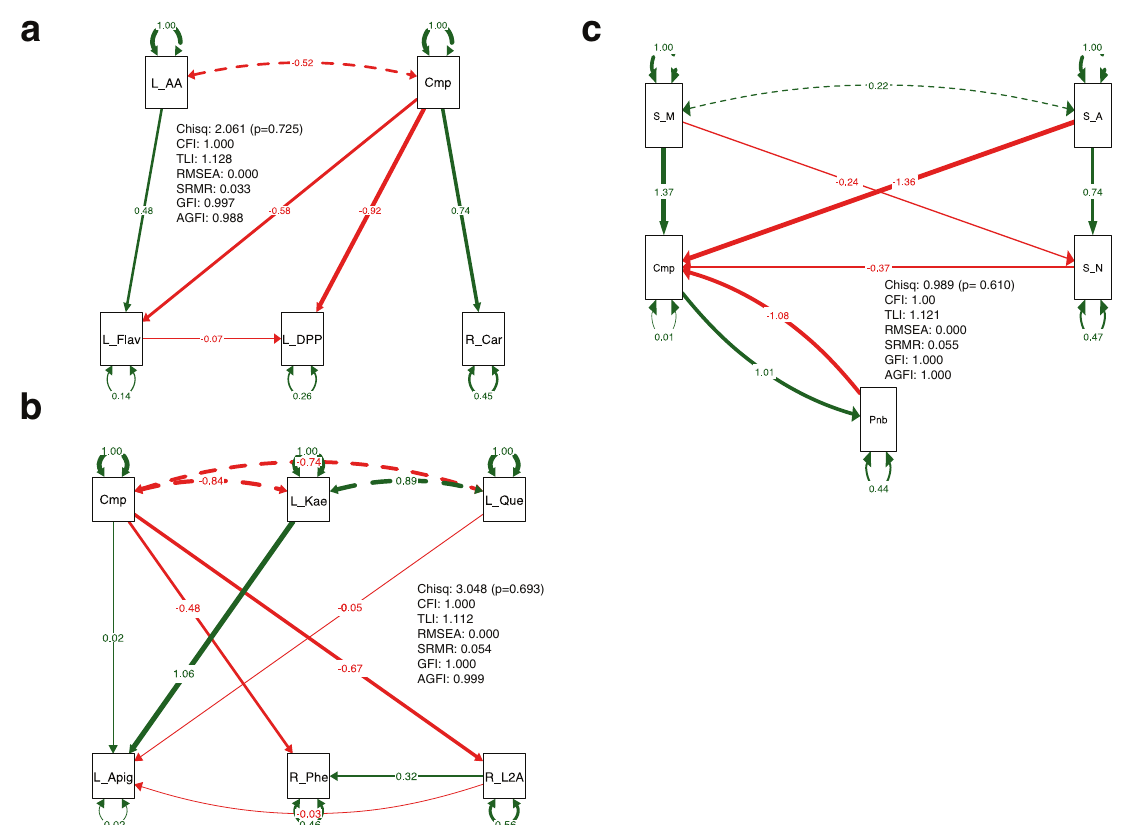
Fig. 5 The relationship of the leaf and root metabolite candidates associated with compost amendment was visualized by structural equation modeling in the regression groups selected in Tables S1 and S2. Standardized β coef fi cients are reported. The green and red colors show positive and negative associations, respectively. a Shows the sempath linked with amino acids, carotenoids, fl avonoids, DPPH activity, and compost. b Shows the sempath linked with apigenin 7-O-neohesperidoside, kaempferol-Gal-Rha, and quercetin Glc as fl avonoids in the leaf and L-2-aminoadipate and phenylalanine in the root and compost. c Shows the sempah linked with soil metabolites, Paenibacillus , and compost.The abbreviations are as follows: Cmp, compost; L_AA, total amino acid contents in the leaf; L_Fav, total fl avonoid contents in the leaf; L_DPP, DPPH activities in the leaf; R_Car, total carotenoid contents in the root; L_Apig, apigenin 7-O-neohesperidoside in the leaf; L_Kae, kaempferol-Gal-Rha in the leaf; L_Que, quercetin Glc in the leaf; R_L2A, L-2-aminoadipate in the root; R_Phe, phenylalanine in the root; Pnb, Paenibacillus ; S_A, L-2 aminoadipate; S_N, nicotinamide; S_M, S -methyl L-cysteine. The fi t indices are shown in the path as follows: Chiq, chi-square χ 2 ; p value, p values (chi-square); CFI comparative fi t index, TLI Tucker – Lewis index, RMSEA root mean square error of approximation, SRMR standardized root mean residual, GFI goodness-of- fi t index, AGFI adjusted goodness-of- fi t In examining the degree of optimization of these as a group, calculations using two types of statistical causal inference, causal mediation analysis (CMA) and BayesLiNGAM, were performed to test whether the factor groups on the structural equations were important as a group. CMA revealed that a single mediation (indirect) effect (ACME) was not calculable or without signi fi cant values (Tables S4, S5, and S6). These calculated results estimated a strong relationship for each group. Therefore, the causal interactive relationships within each optimal model of the leaf, root, and soil were investigated based on a calculation by BayesLiNGAM (Fig. S12). The highest causal interactive relation- ships (top six) were mainly shown from compost but not always. This may mean that the compost supports it while the physiological responses of the carrot and/or the soil themselves are prioritized. These results pointed to the importance of the optimal model as a whole group, as well as the optimal model group estimated for the leaf and root. Therefore, nitrogen compounds were involved in these structural equations for leaves, roots, and soil. Based on these observations, the genus Paenibacillus derived from compost was explored, followed by a search for its function within the compost itself.